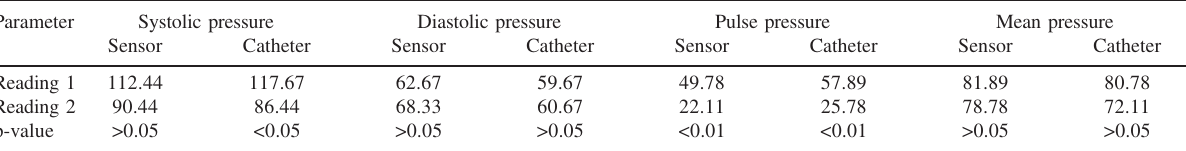
Table 4 - Average pressure levels (mmHg) from Readings 1 and 2, and p-values.